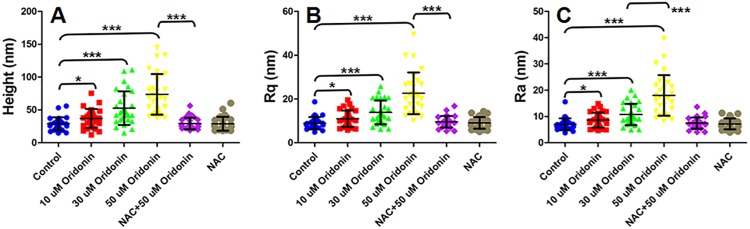
Statistical results of NAC reversed oridonin induced oesophageal cancer KYSE-150 cell membrane ultrastructural changes determined by AFM.(A) Height distribution, (B) root-mean-squared roughness (Rq) and (C) average roughness (Ra) analyzed from 2×2 μm frame ultrastructure images of KYSE-150 cells, n = 30, *p<0.05, ***p<0.001.